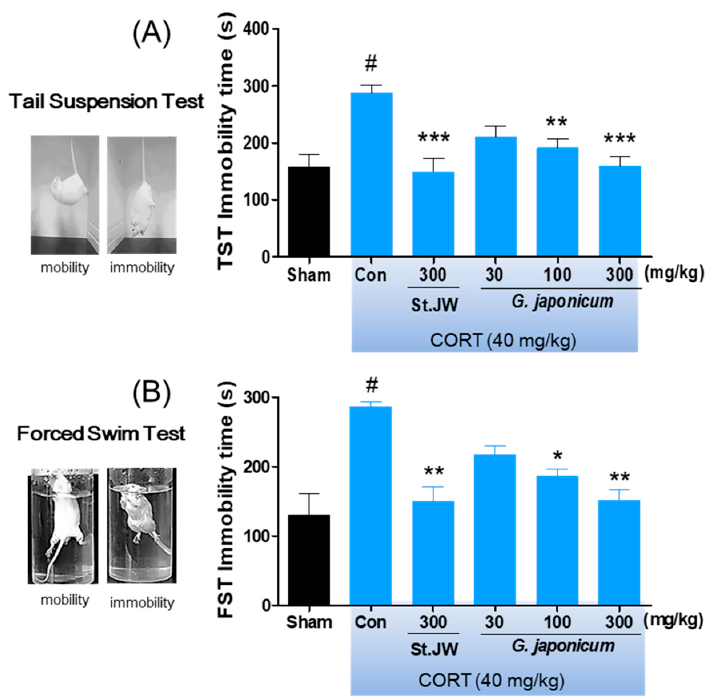
Figure 5. Effects of G. japonicum extract on the ( A ) tail suspension test (TST) and ( B ) forced swim test (FST) in CORT-induced depressive mice. CORT injections significantly increased the immobility time (s), while treatment with 100 and 300 mg/kg G. japonicum extract significantly decreased it. Results are presented as mean ± SEM. # p < 0.05 versus the sham group; *** p < 0.001, ** p < 0.01, and * p < 0.05 versus the CORT-injected control group (Con).